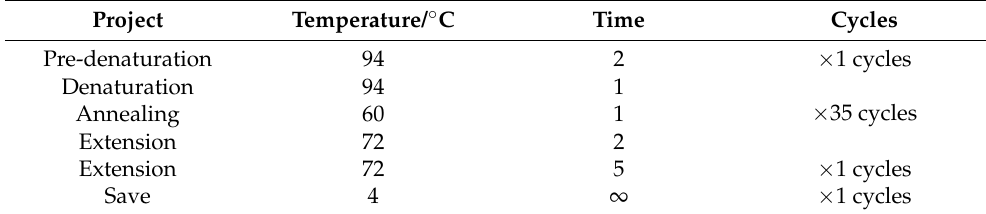
Table 3. The parameters for PCR